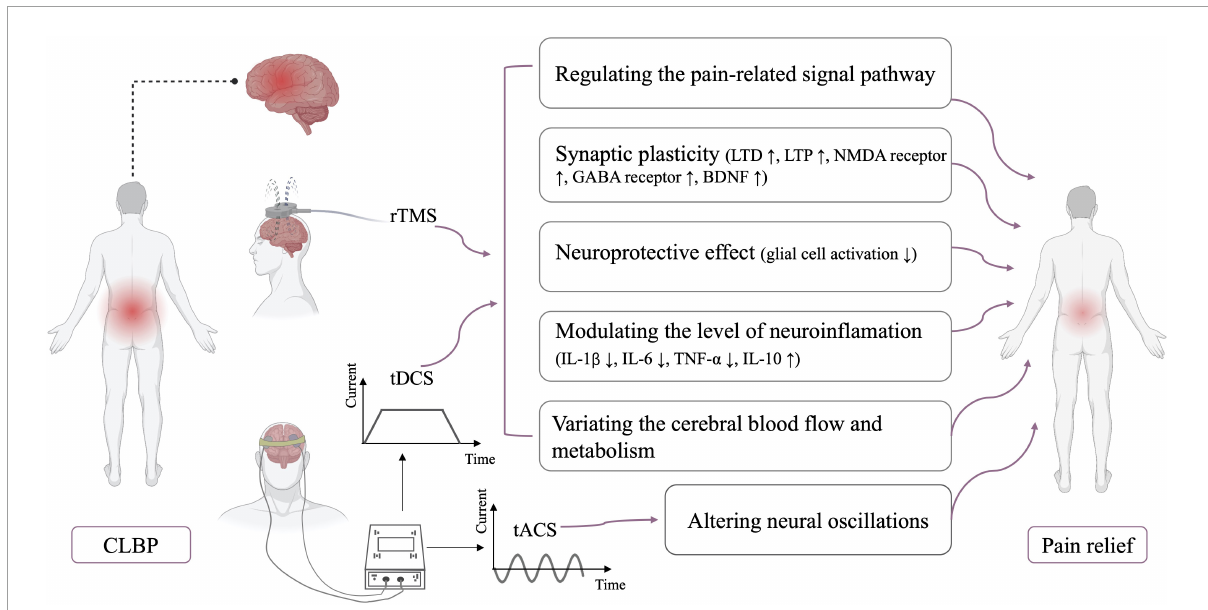
FIGURE1 Neurophysiological mechanisms of NIBS. CLBP, chronic low back pain; LTD, long-term depression; LTP, long-term potentiation; NMDA receptor, N -methyl- D -aspartate receptor; GABA receptor, gamma-aminobutyric acid receptor; BDNF, brain-derived neurotrophic factor; IL, interleukin; TNF, tumor necrosis